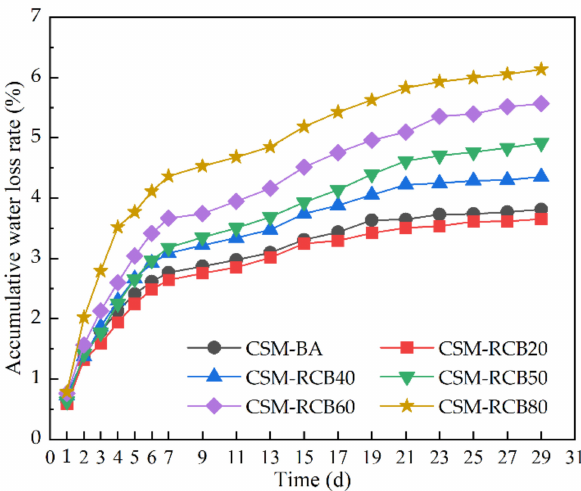
Figure 9. The accumulative water loss rate of CSM changing with